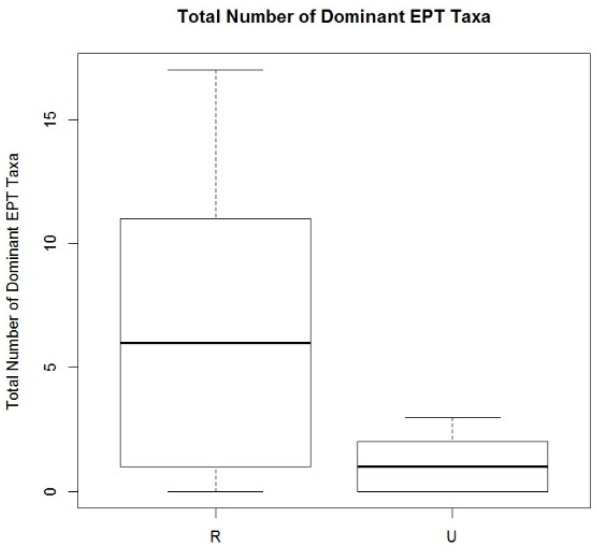
Figure 5. Total Number of Dominant EPT Taxa for mountain (M), Piedmont (P), and coastal plain (C) streams ( n = 79).